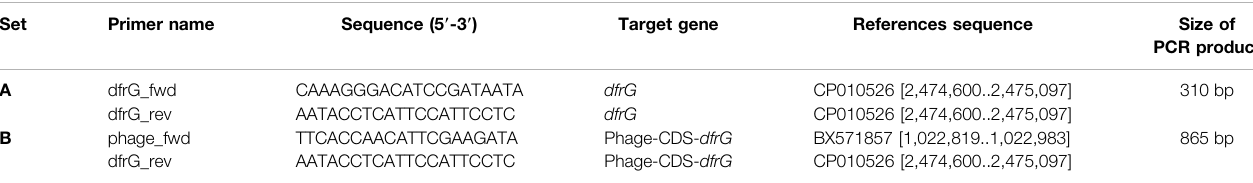
TABLE 1 | Primer for detecting the local proximity of the dfrG and phage-CDS genes in the bacterial chromosome and the isolated phage-DNA. Set